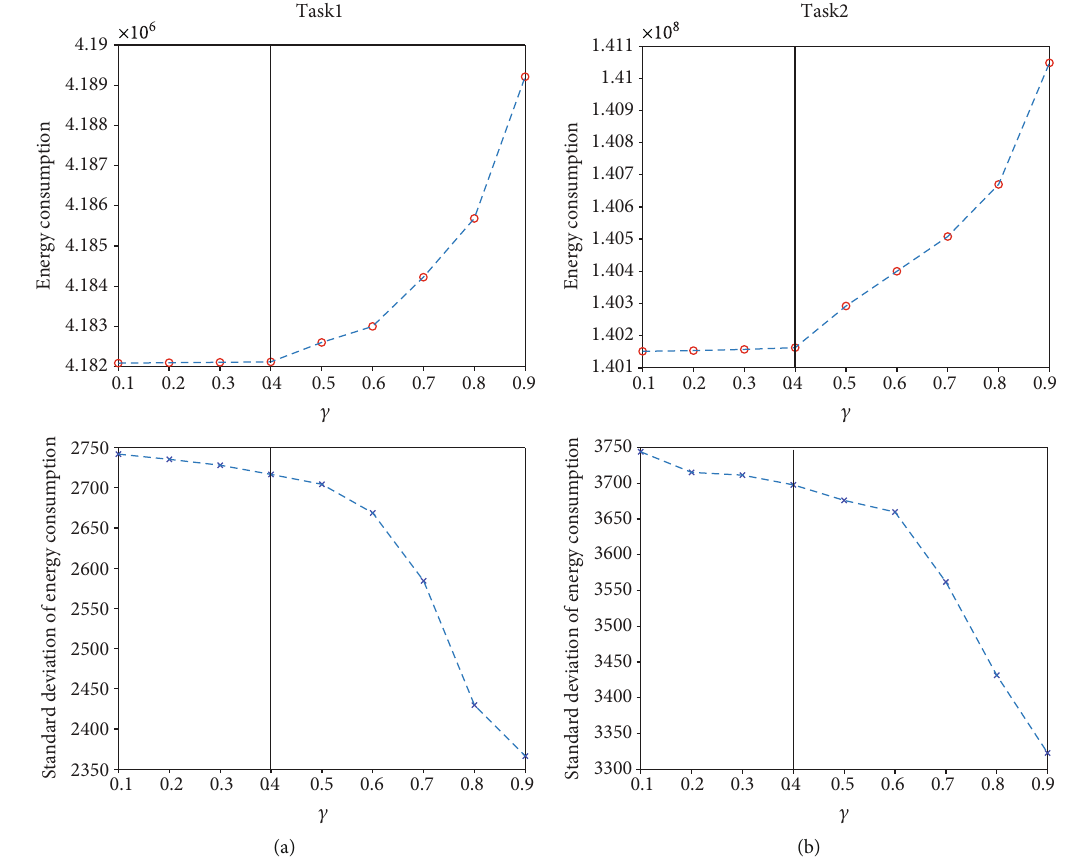
Figure 10: The e ff ects of the parameter γ on the energy consumption and its standard deviation: (a) in task1; (b) in task2. Table 7: The comparison results of the cooperative task with di ff erent task assignment methods. Relay